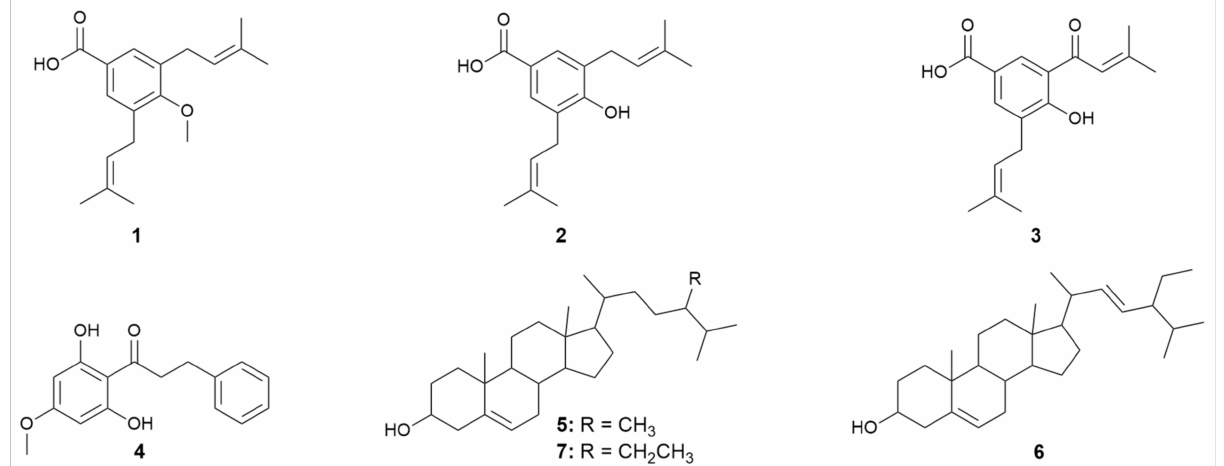
Figure 1. Isolated and identified compounds in the aerial part of P. pesaresanum